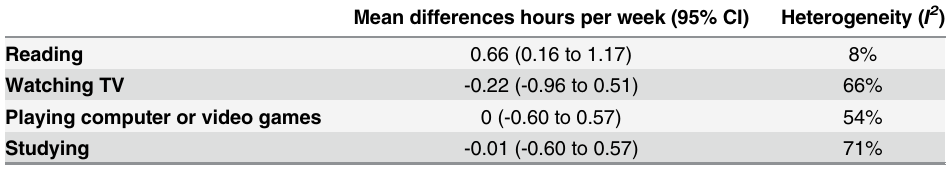
Table 1. The difference in time spent on near work activities between myopes and non-myopes.